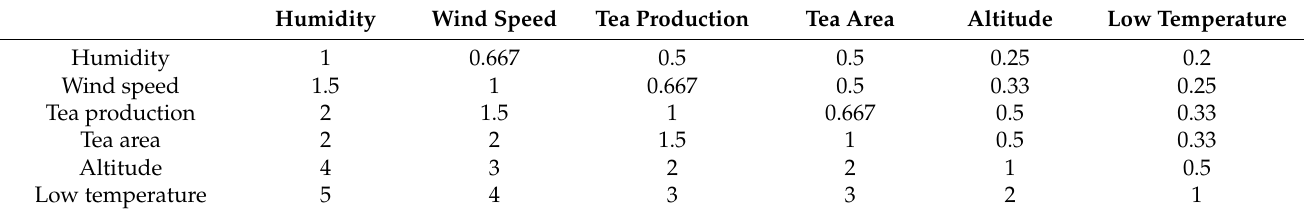
Table 2. The construction of judgment matrix results.